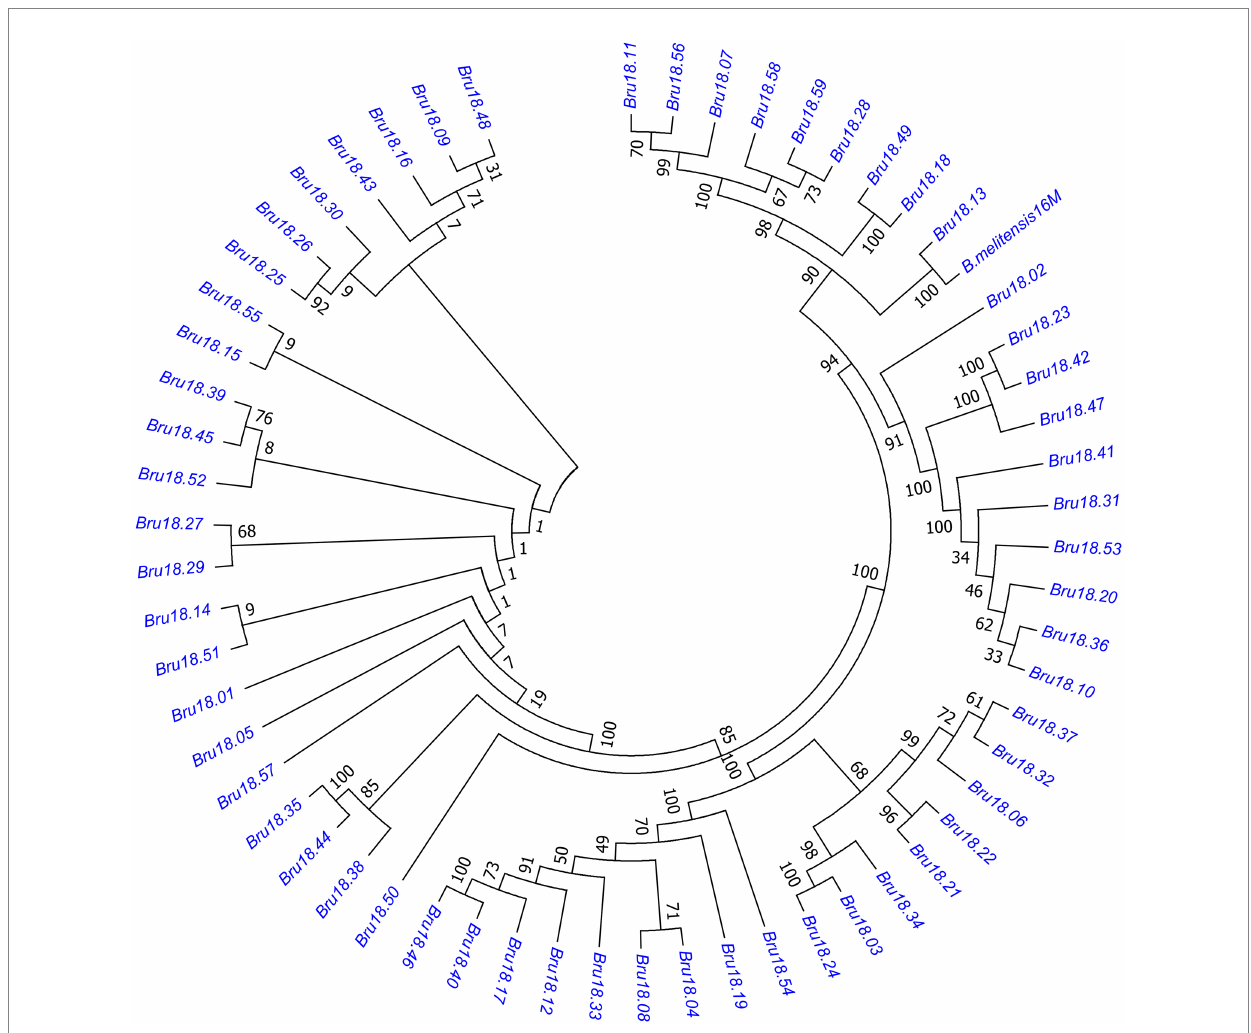
FIGURE 3 Phylogenetic tree of Brucella isolates. The evolutionary history was inferred using the neighbor-joining method and the evolutionary distance was calculated using the Poisson correction method. The evolutionary tree of the relationships among 59 strains of Brucella and 16 M can be roughly divided into five small closely related phylogenetic groups with little genetic